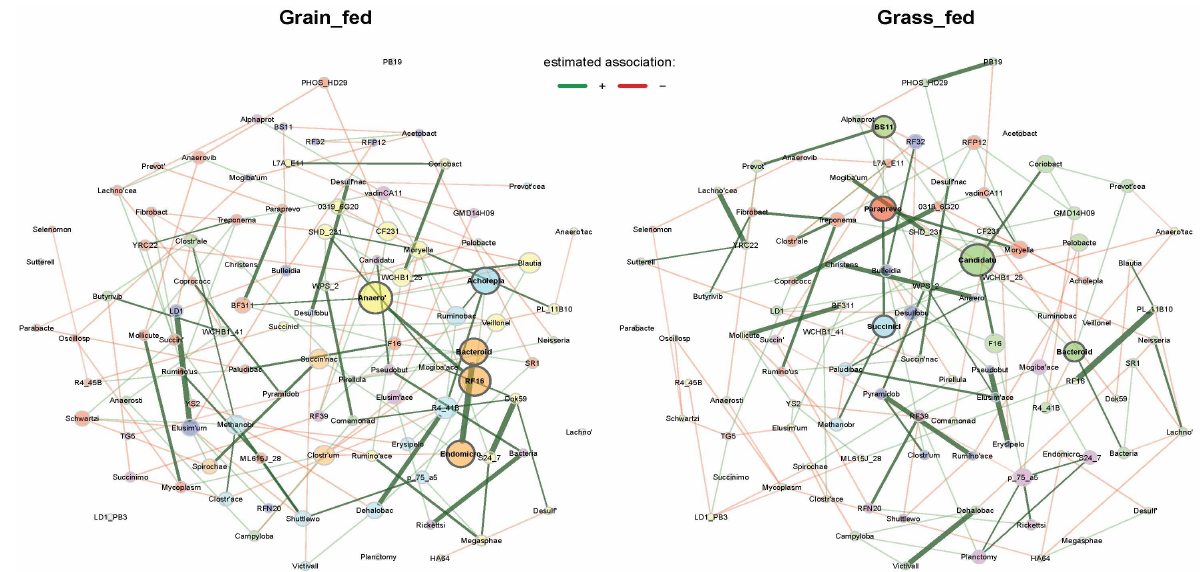
Figure 7. Comparisons of rumen microbial association networks at genus level between grass-fed and grain-fed group. The layout computed for grain-fed network was applied in both networks for comparison. Unconnected nodes in both groups were removed. Genera names were abbreviated.